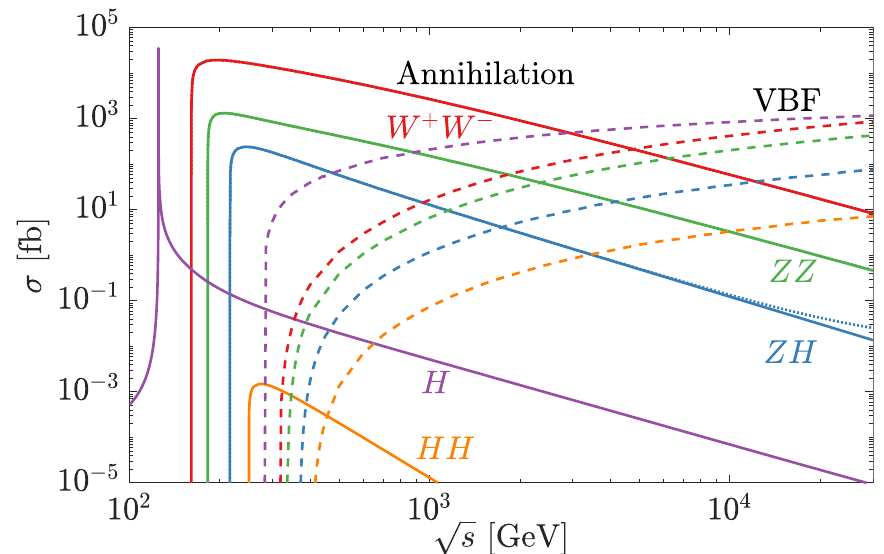
Figure 4 . The cross sections of diboson production at a µ + µ − collider as a function of the c.m. √ energy s . The solid and dotted lines are for the direct annihilation with muon Yukawa coupling as κ µ = 1 and κ µ = 0 (2) (hardly visible), respectively. The dashed rising curves are the (charged) vector boson fusions (VBF), µ + µ − → ν µ ¯ ν µ X , calculated using the fixed-order (FO) approach with a cut on the invariant mass of ν µ ¯ ν µ pair M ν > 150 GeV . All calculations are carried out with µ ¯ ν µ Whizard 2.8.5